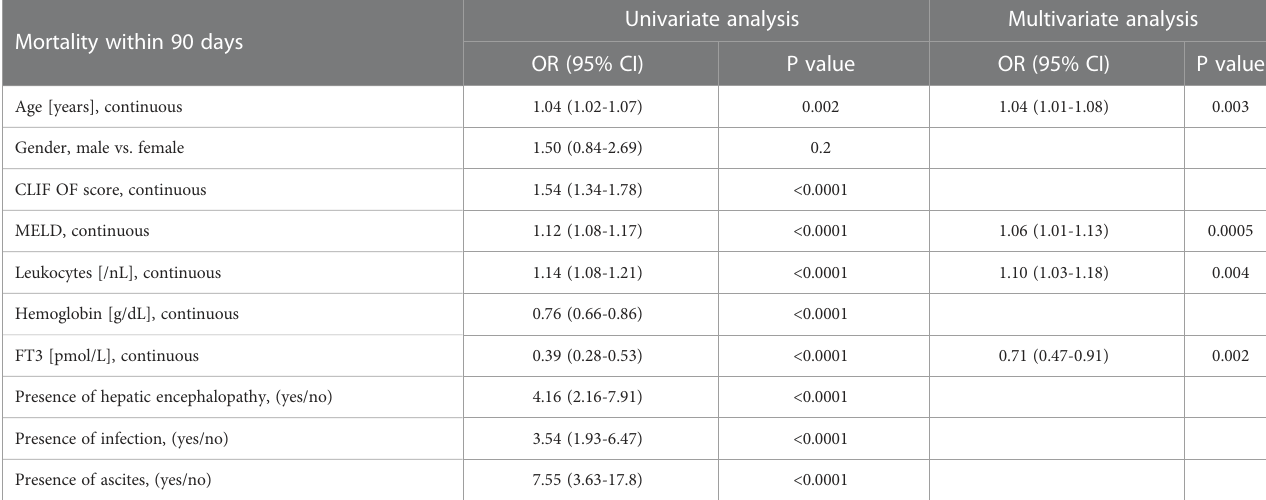
TABLE 2 Cox-regression analysis of 90-day mortality.